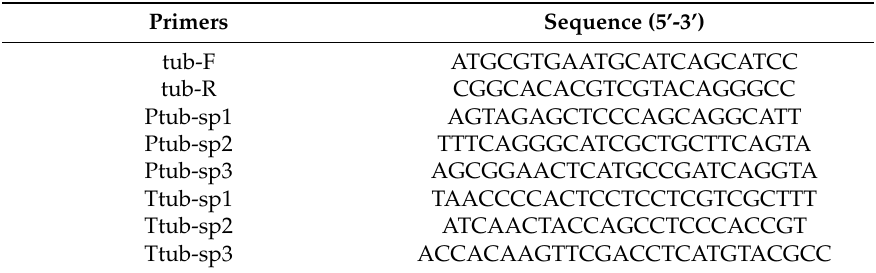
Table 1. Primers prepared for the tub promoter and terminator via genome walking.